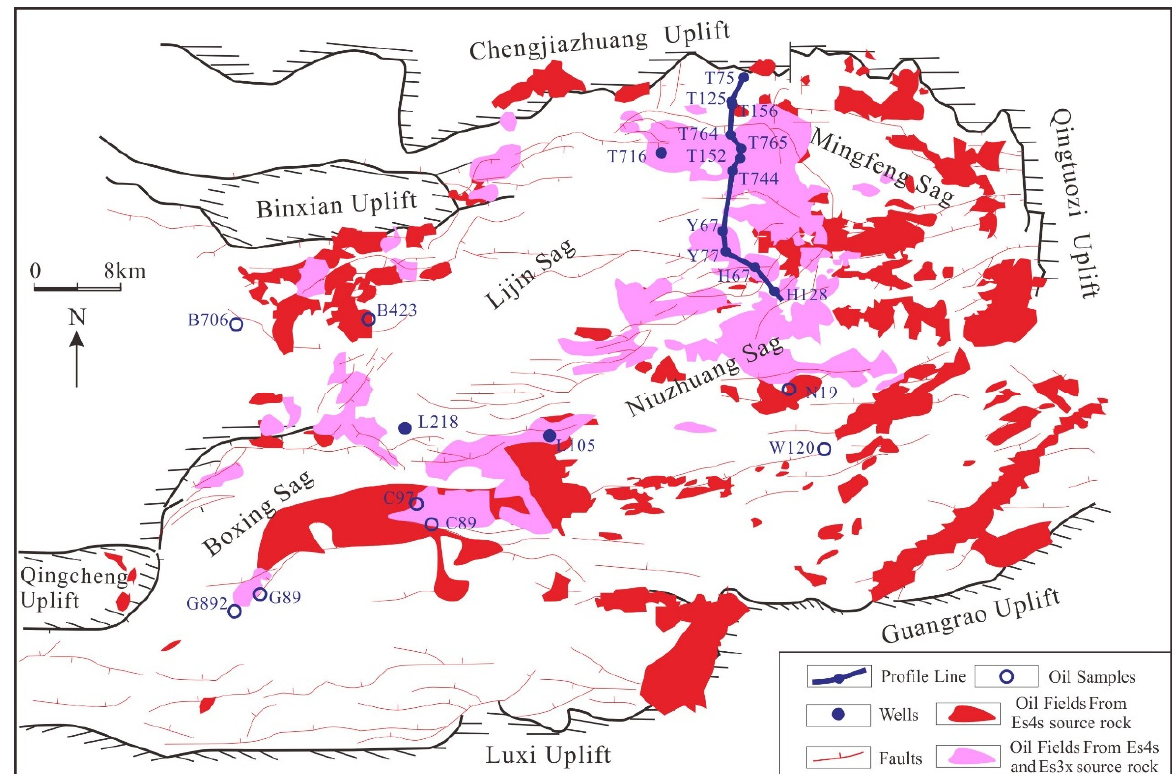
Figure 1. Map of structural division, fault distribution, the distribution of oil fields related to the source of Es4s member, and the mixed source in Dongying Depression.